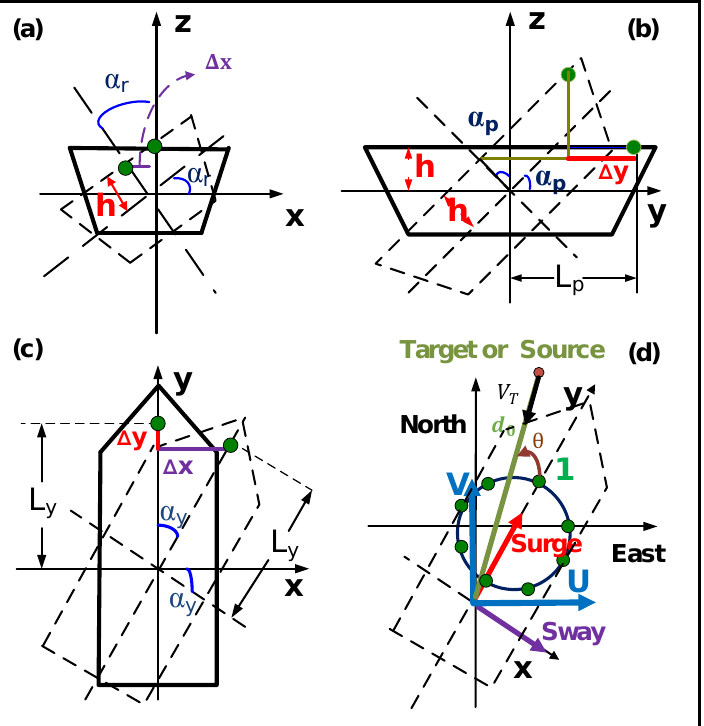
Figure 4. Kinematics of the platform motion (Ant. 1): ( a ) roll rotation, ( b ) pitch rotation, ( c ) yaw rotation, ( d ) easterly and northerly